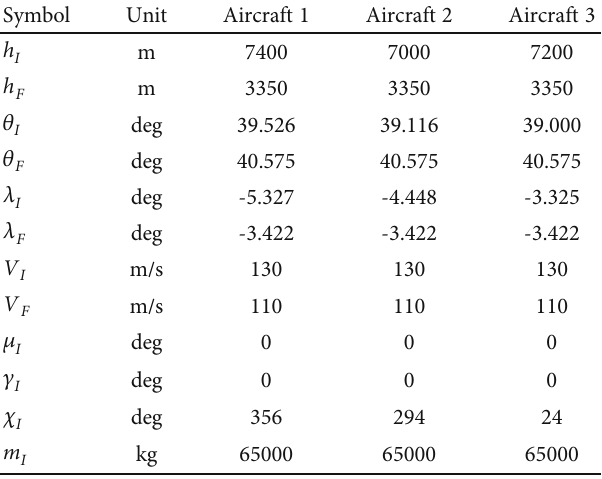
Table 1: Boundary conditions for Experiment 1 and Experiment 3.